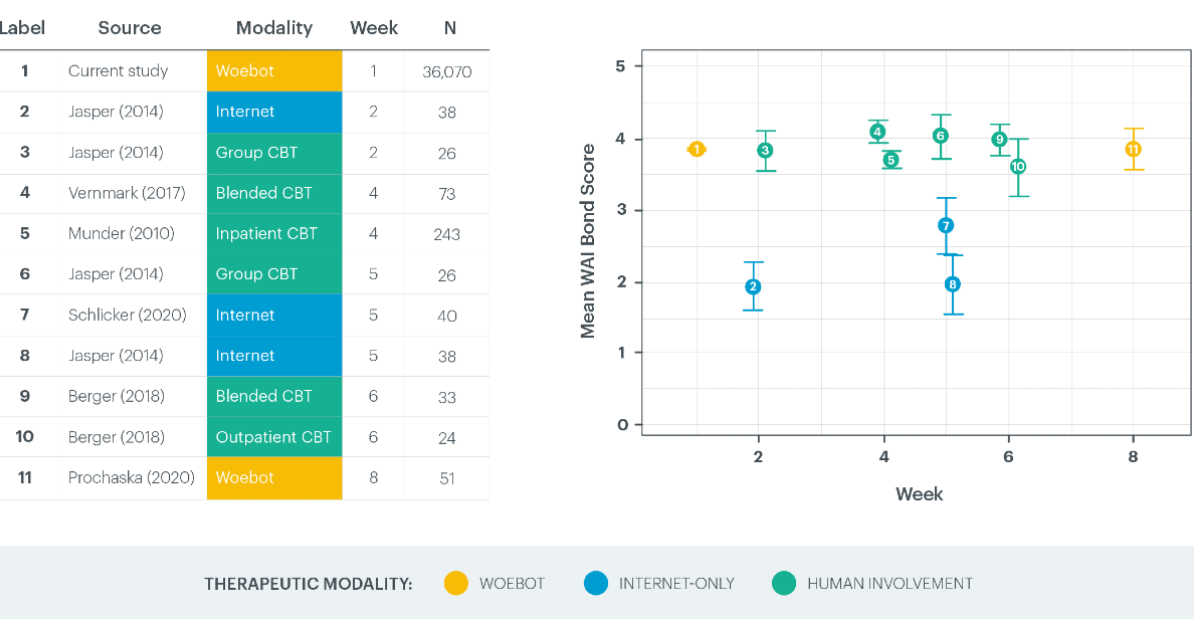
Figure 2. Comparison of Working Alliance Inventory-Short Revised bond subscale scores across therapeutic modalities. Means and corresponding 95% CIs for working alliance bond scores from this study and from recent reviews of the literature [11,13-15,17-19] are stratified by the week that the scores were recorded. Studies are colored based on the therapeutic modality. Due to the large sample size of this study (N=36,070), the 95% CI is narrow and overlaps with the dots that display the estimated means. For multiple studies that reported data on the same week, the dots are shifted minimally on the x-axis to avoid overlap and to provide easy readability. WAI: Working Alliance